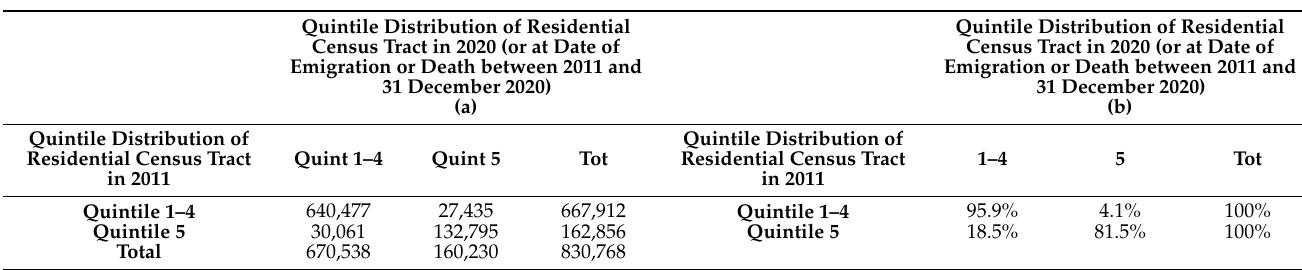
Table A7. ( a ) Temporal comparison of the dichotomous classification of the quintile distribution of the deprivation of census section of residence (according to the deprivation index used in this study [31]) and according to between 2011 (census) and 2020 (as observed in the civil registry) in the city of Turin, capital of Piedmont Region; ( b ) % of individuals who kept or changed their rank in the dichotomous classification of the quintile distribution of the deprivation index of their census section between 2011 and